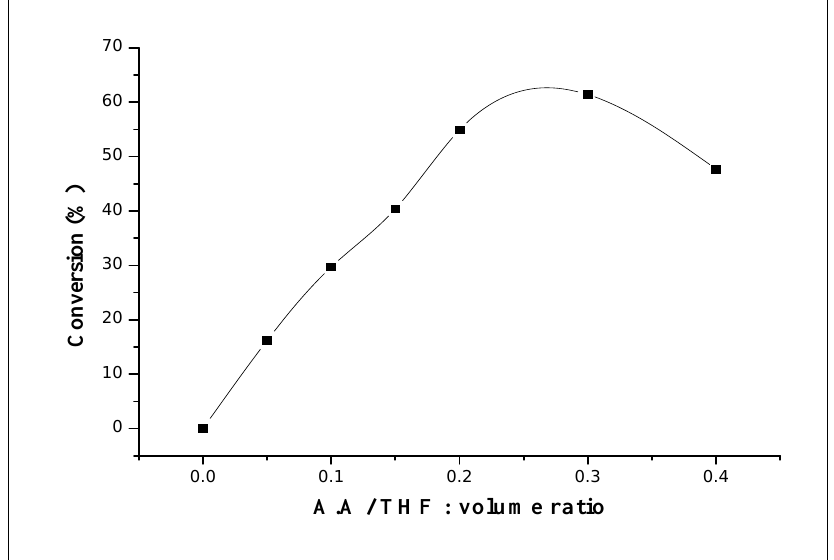
Figure 3. Effect of AA proportion on the yield of poly(THF) catalyzed by 0.1 g